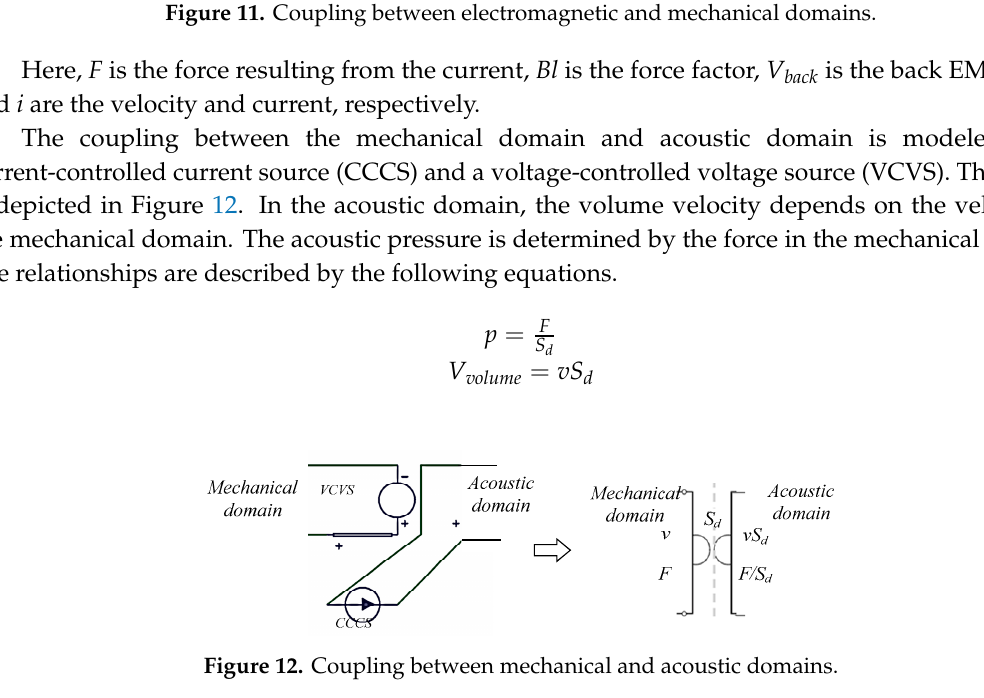
Figure 13. Equivalent circuit of an earphone (without Helmholtz protector). 3. Parameter Identification 3.1. Electromagnetic Parameter Identification Electromagnetic parameter identification is based on the static magnetic FEM. The boundary condition is shown in Figure 14. The vector potential of the outside air region is zero. The governing equations are